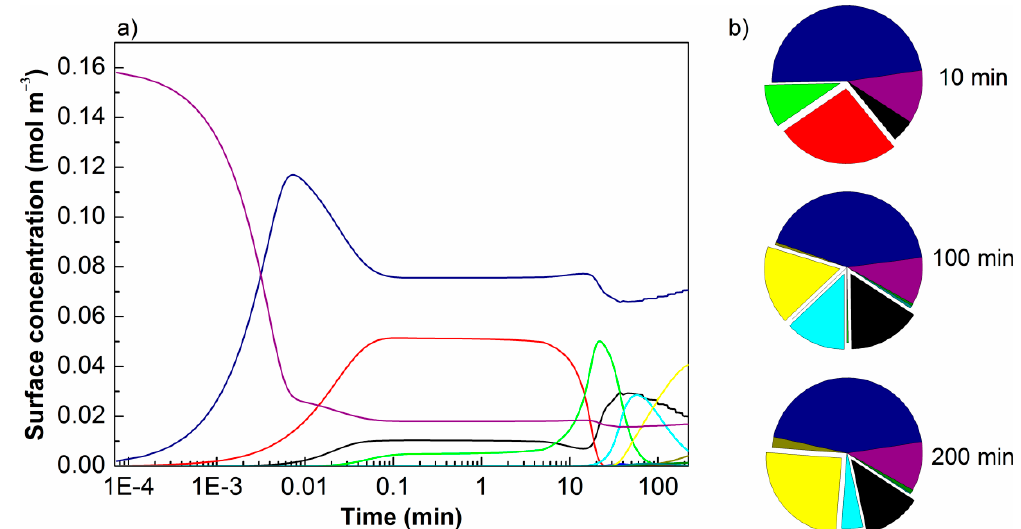
Figure 9. ( a ) Surface concentration on the Ru/C-Fe 2 O 3 -300 catalyst over the entire reaction time presented in log scale (HMAB–red, HMPB–green, HPB–blue, HMPC–cyan, PB–magenta, HPC–yellow, PC–dark yellow, IHMAB–wine, HHPC–dark cyan, hydrogen–black, solvent–navy, vacant active sites–purple); ( b ) Ru/C-Fe 2 O 3 -300 coverage by each component in % at 10, 100, and 200